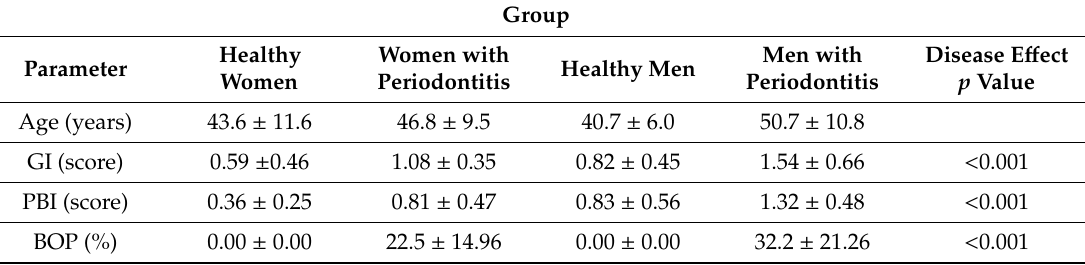
Table 1. Oral health indexes of